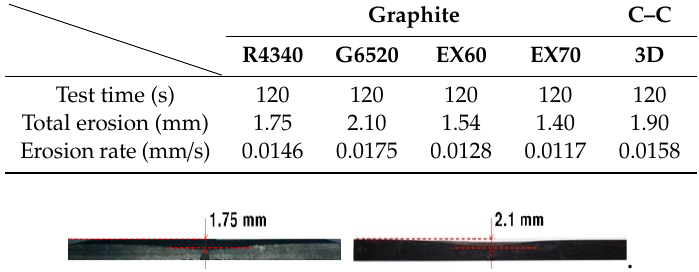
Table 3. The measured erosion of graphite and the C–C composite and their erosion rates. Graphite